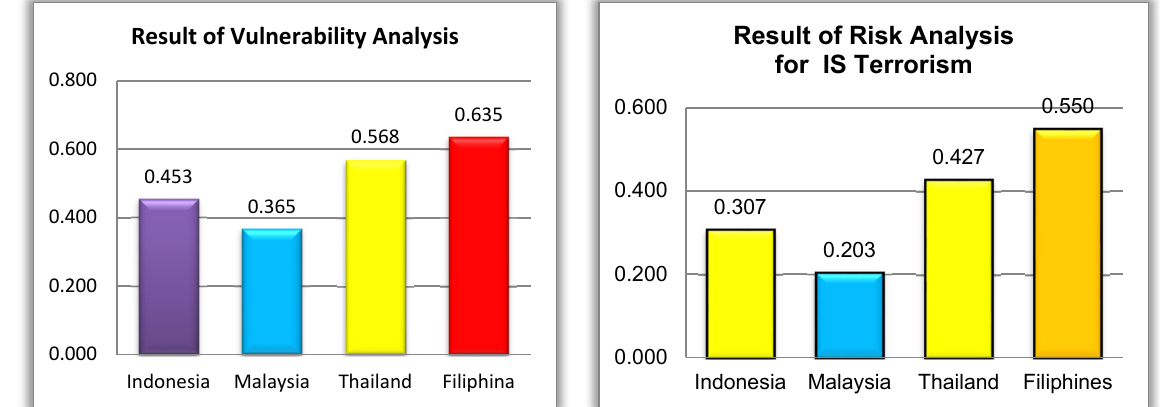
Fig. 5. Graph of Vulnerability Aspect for Risk Analysis Score (T)